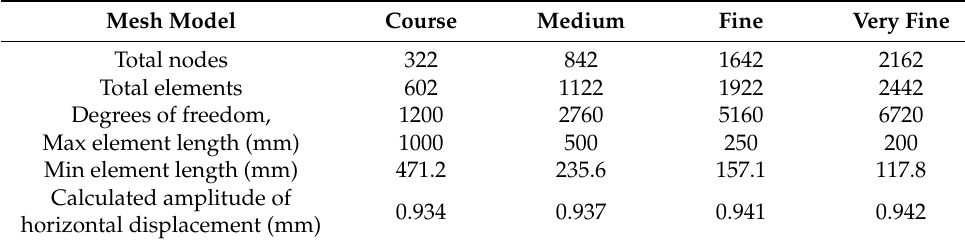
Table 2. Models and results of the convergence